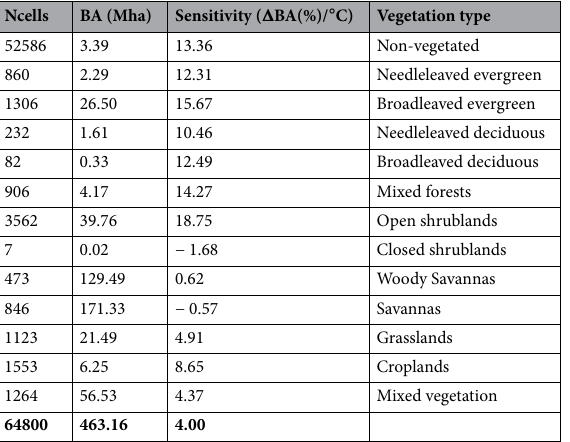
Table 3. Sensitivity of different vegetation types to increase in temperature. Compared to a decrease in savannas of 0.57%, there is a disproportionately positive sensitivity of burned area to temperature in forests and open shrublands. Numbers in bold indicate global